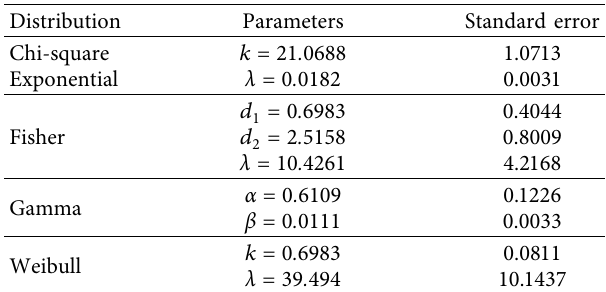
Table 13: Cyber-related fraud loss frequency distribution